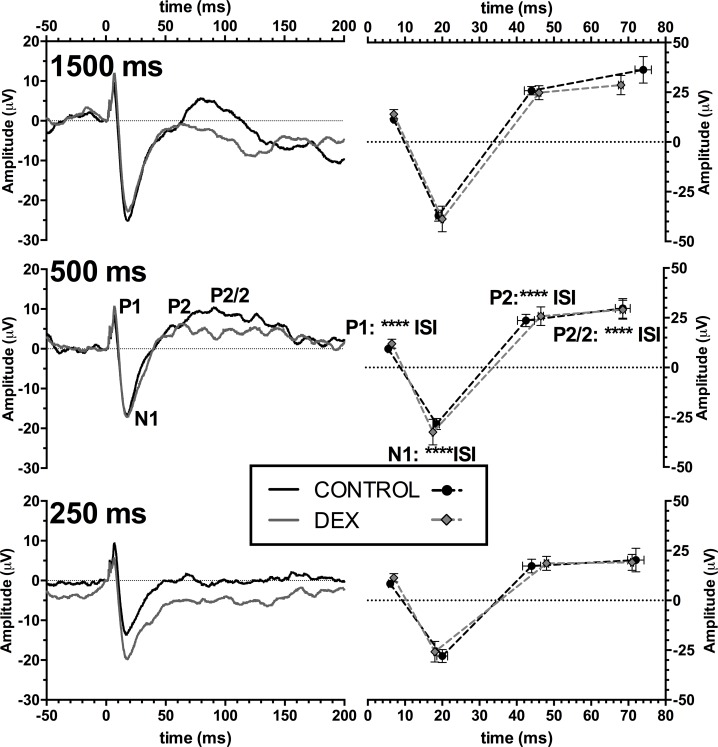
Middle latency auditory evoked potential (MAEP) outcomes.Group grand mean averages for MAEP responses (Left Column) at different inter-stimulus intervals (interval indicated in bold text) assessing the fatigue effects of evoked the peaks. (Right Column) peak latency and peak-to-peak amplitudes at different interstimulus intervals. Analysis used mixed model 2-way ANOVA, main effects of interstimulus interval (ISI) indicated above the relevant peak in the center panel. Significant differences: **** p < 0.0001.